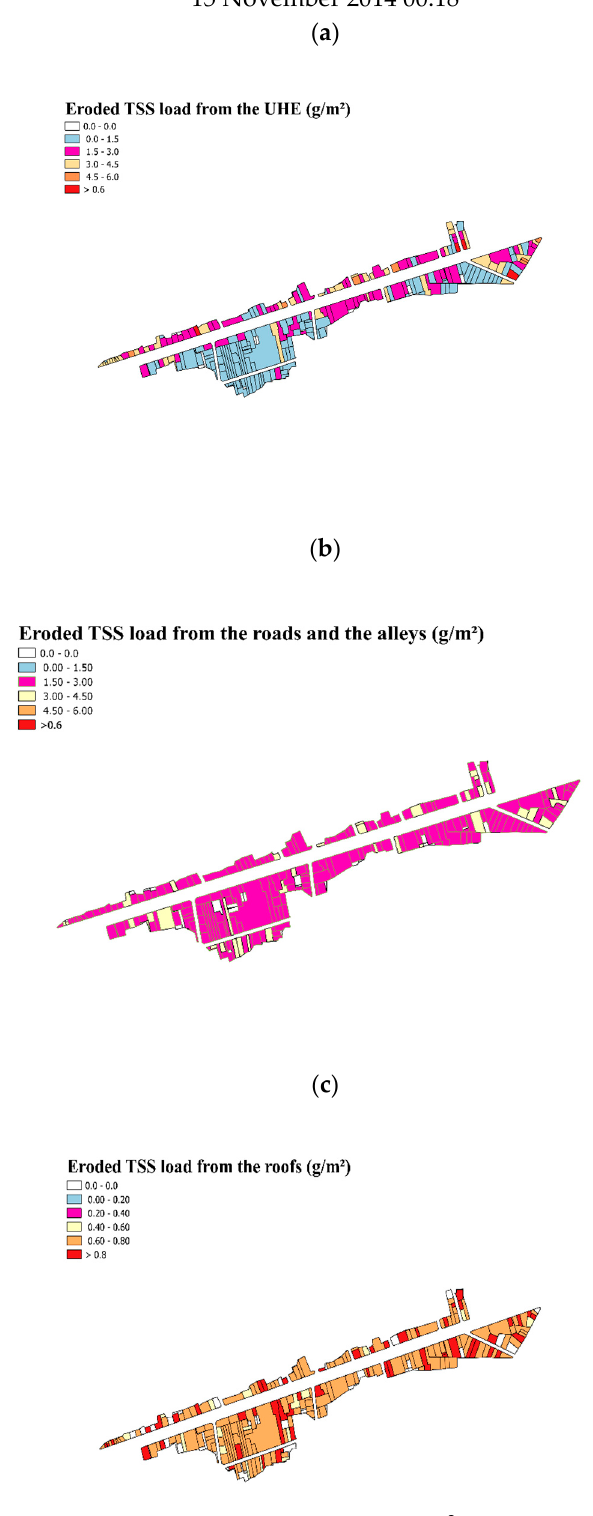
Figure 7. Spatial variability of mean TSS washed-off loads (g/m 2 ) from the ( a ) UHE, ( b ) roads and alleys and ( c ) roofs for the rainfall event of 15th November.